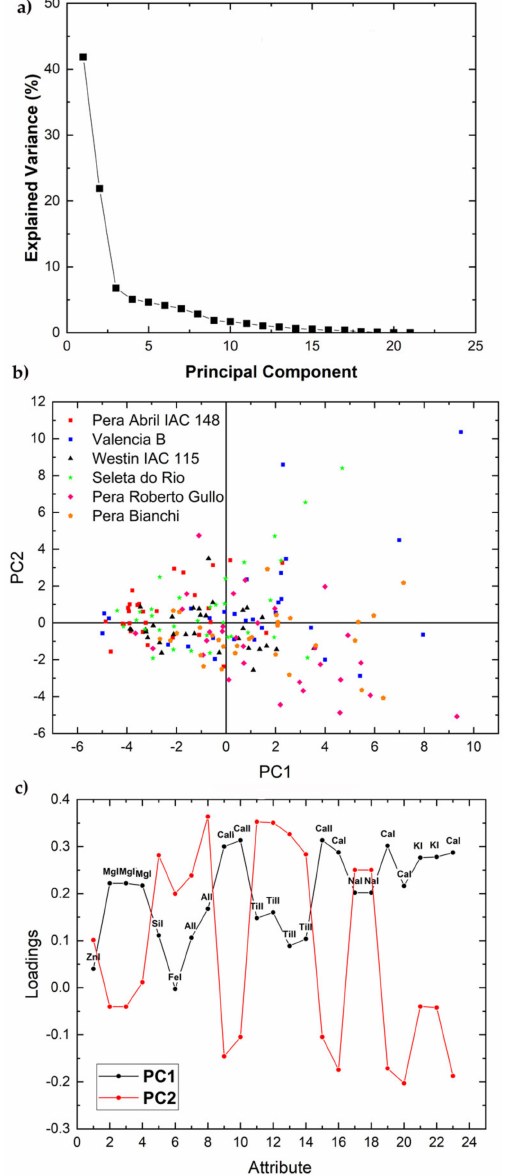
Figure 5. Scree plot ( a ), PCA 2-dimensional score plot of PC2 versus PC1 ( b ), and loading plot showing how each variable correlates to each PC ( c ) for the six accessions of the Common variety of set